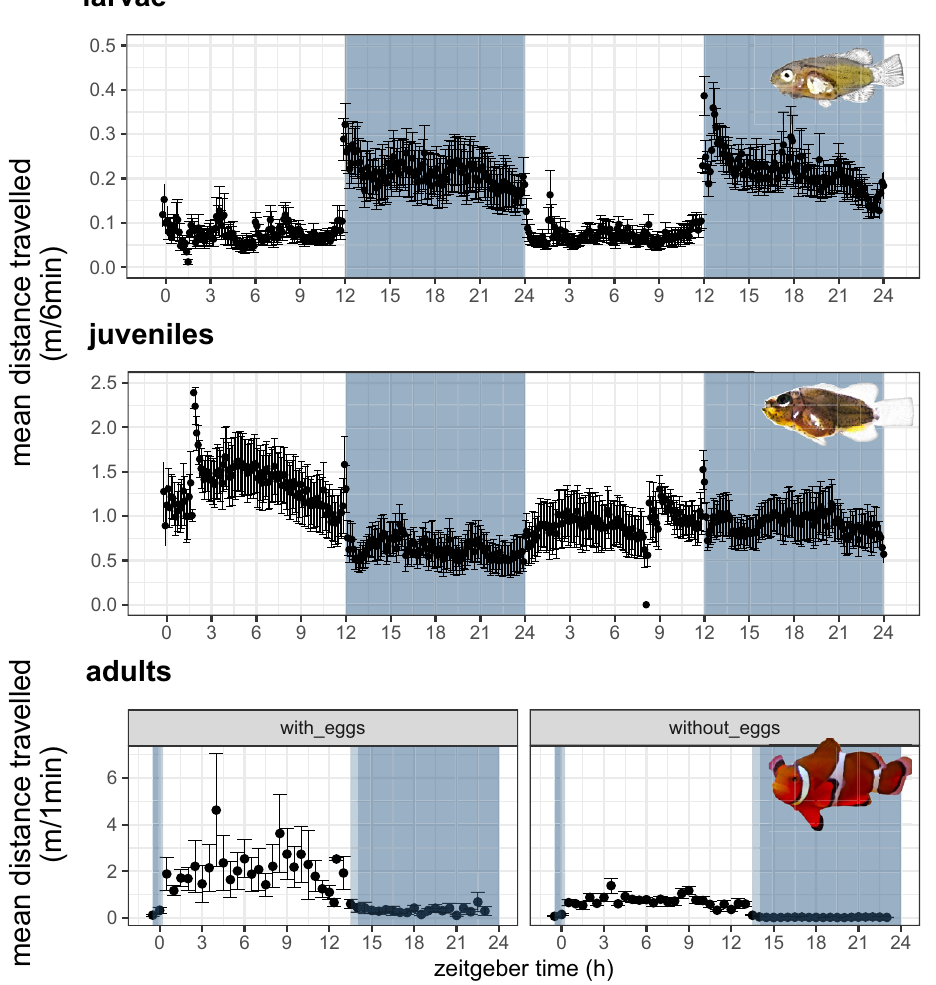
Figure 1. Representative locomotor activity determined by mean distance travelled ± SEM of Amphiprion ocellaris in 11–13 dph old larvae (n = 15–23), ca. 100 dph old juveniles (n = 9–18) and several years old adults (n = 4). Bluish-grey background refers to lights off. The mean locomotor activity of two consecutive days (larvae and juveniles) in m/6 min or two independent days (adults) in m/1 min are shown, dependent on zeitgeber time (h). Movement of larvae and juveniles was tracked continuously and the distance covered was summed up per 6 min. Adults were tracked manually half-hourly for one